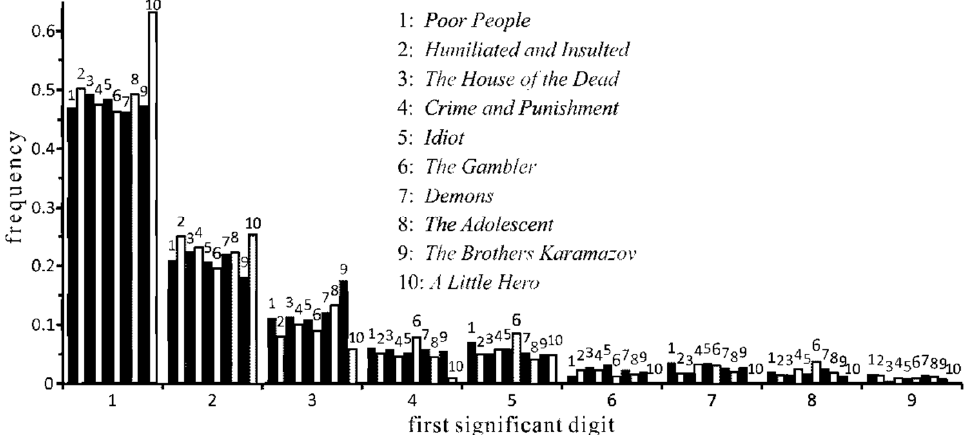
Figure 4. The distribution of the first significant digits of numerals in Dostoevsky’s texts. In addition to voluminous works (Nos. 1–9), a shorter one (No. 10) was analyzed for comparison.